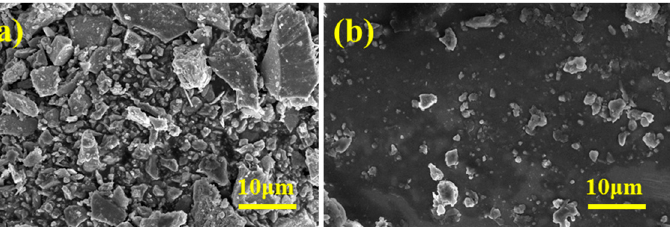
Figure 9. SEM micrographs of the morphology and structure of the consolidated soil for backfilling: ( a ) watered samples and ( b ) suppressed samples.